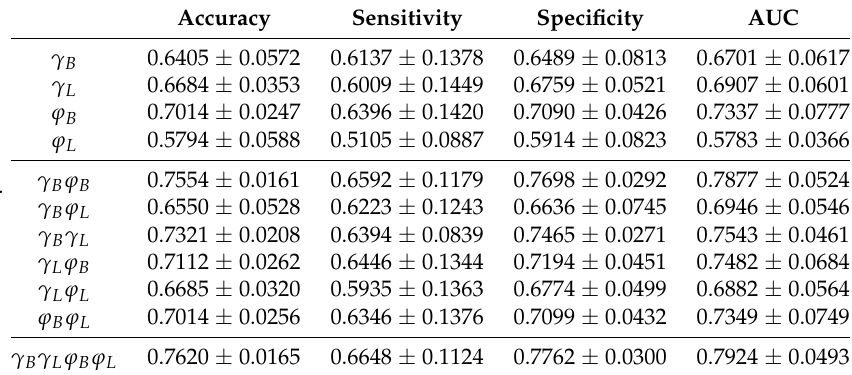
Table 1. AUC, accuracy, sensitivity and specificity related to the exudate detection for E-OPHTHA exudates database taking into account different morphological input vectors to the SVM